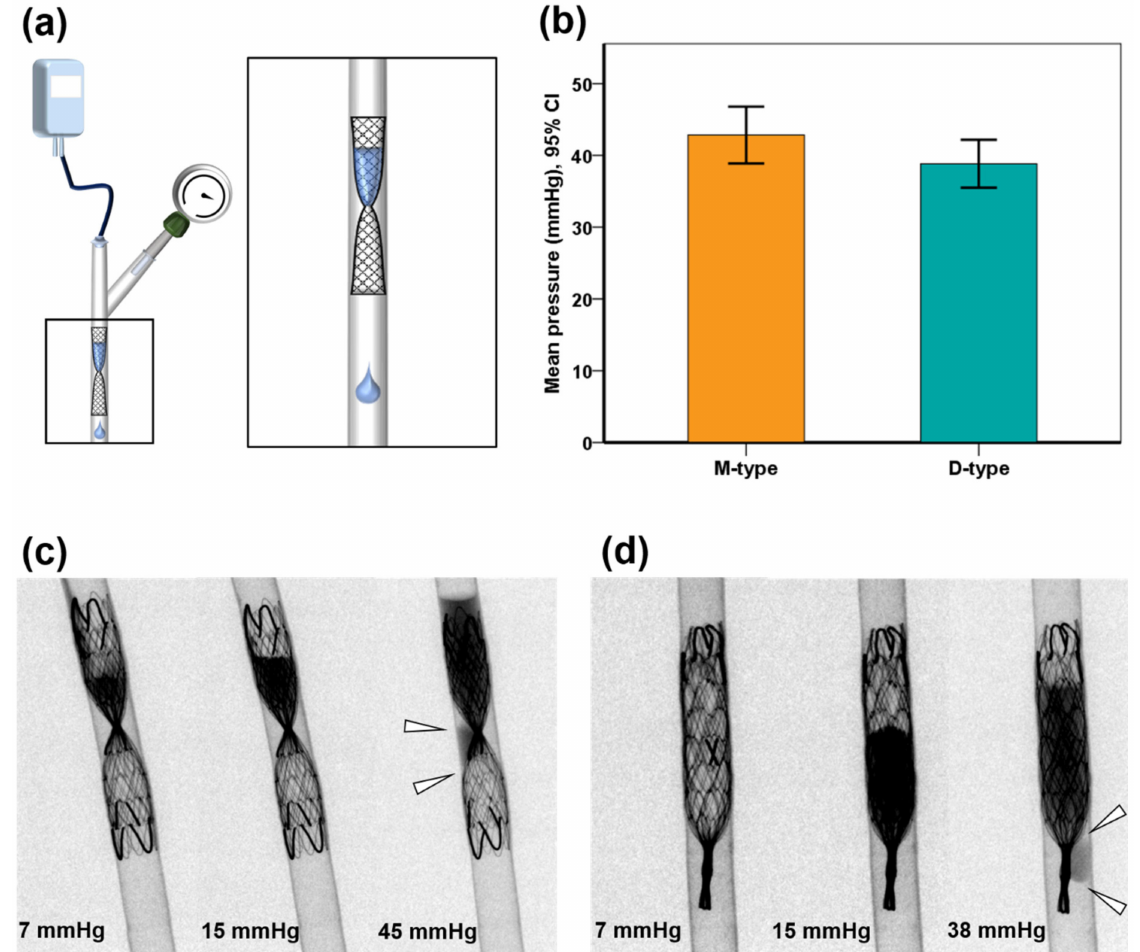
Figure 3. The process of in vitro set-up and the results of experiments. ( a ) Schematic illustration of the in vitro set-up using the 3D-printed phantom. ( b ) Graph showing the mean pressure at the point of the contrast leakage in the M-type and D-type occlusion self-expandable metallic stents (SEMSs). ( c ) Fluoroscopic images obtained during the in vitro experiment using the M-type occlusion SEMS, showing leakage (arrowheads) at 45 mmHg. ( d ) Fluoroscopic images showing the presence of leakage (arrowheads) at 38 mmHg in the D-type occlusion SEMS in the 3D printed phantom. Note: CI, confidence